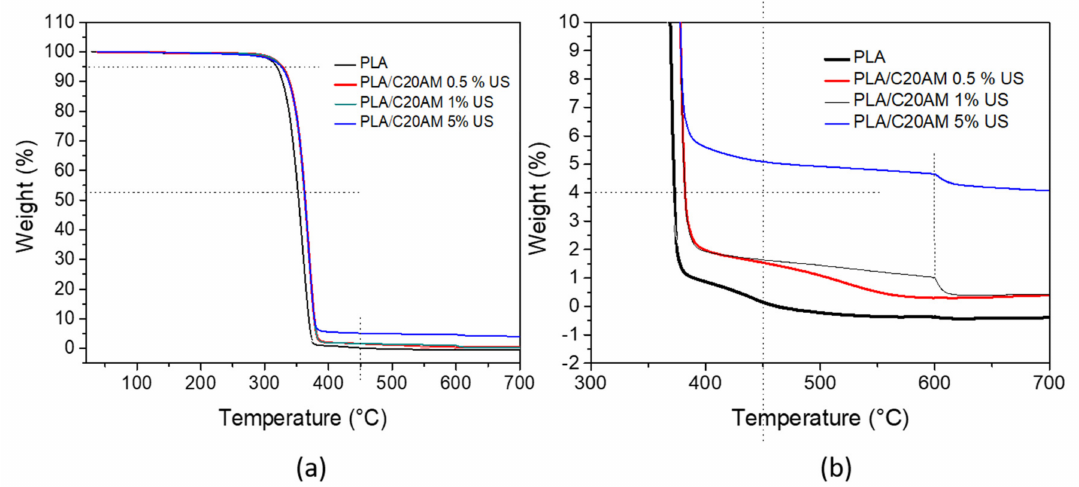
Figure 9. ( a ) Thermogravimetric analysis of the PLA and the nanocomposites obtained and ( b ) close-up of the thermogram obtained from 300 to 700 ◦